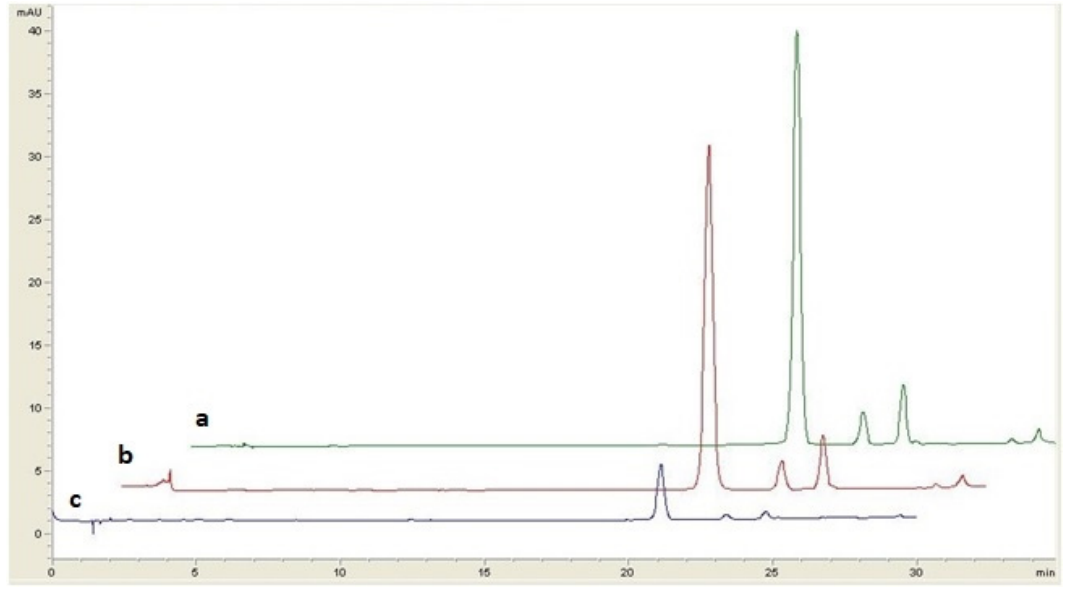
Figure 4. HPLC profiles (532 nm) of anthocyanins from stevia lingonberry jam before ( a ) and after in vitro gastric ( b ) and GI ( c ) digestion.